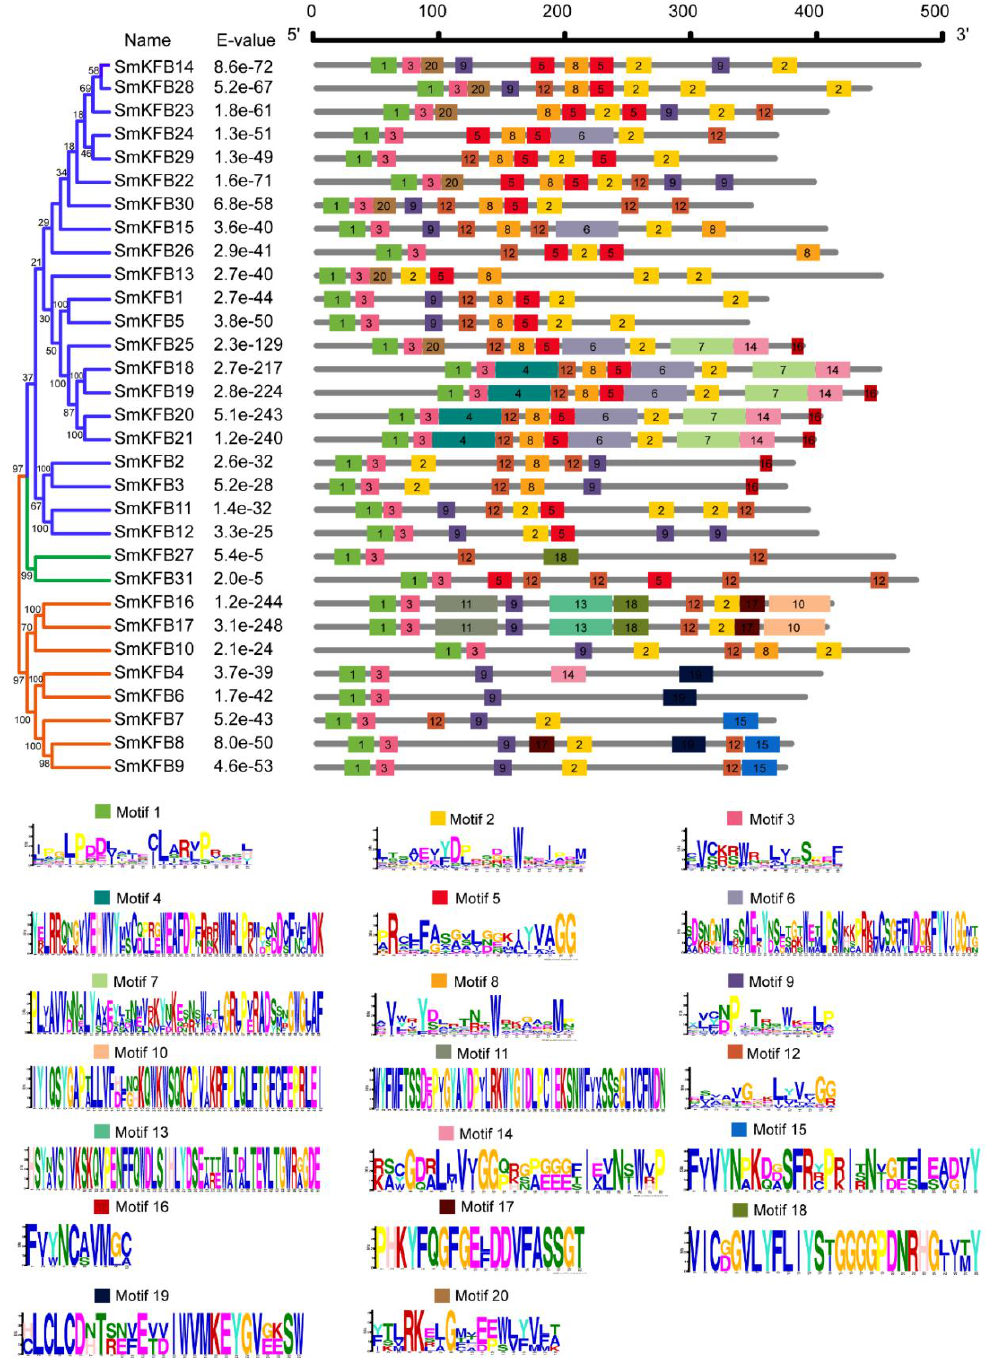
Figure 2. Schematic diagram of conserved motifs in SmKFB proteins of S. miltiorrhiza . The different colored boxes represent different motifs and the box size indicates the length of the motif. Sequence logos are shown on the base side of the figure.